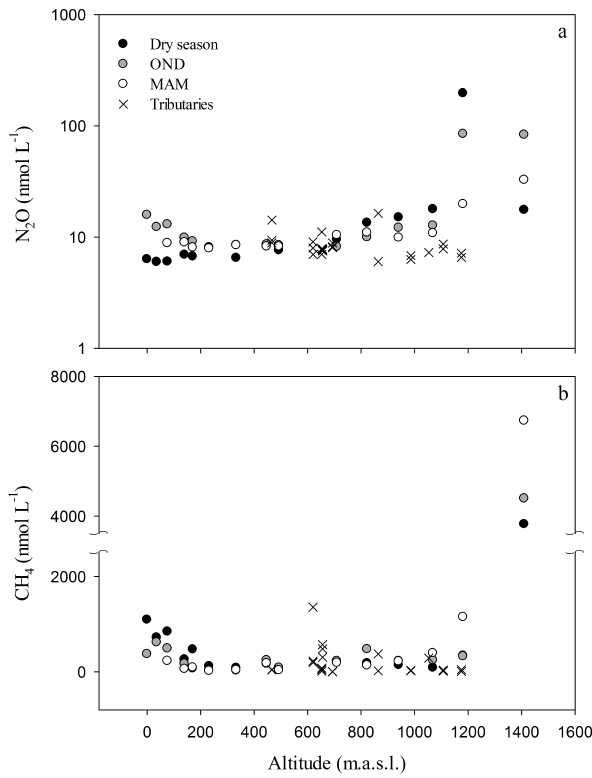
Fig. 5. Altitudinal gradient during dry season (August–September 2011), short rain season (October–December, OND, November 2011) and long rain season (March–May, MAM, April 2012) and tributaries (x, all seasons) of in-stream (a) dissolved N 2 O (nmolL − 1 ) , and (b) CH 4 (nmolL − 1 ) .